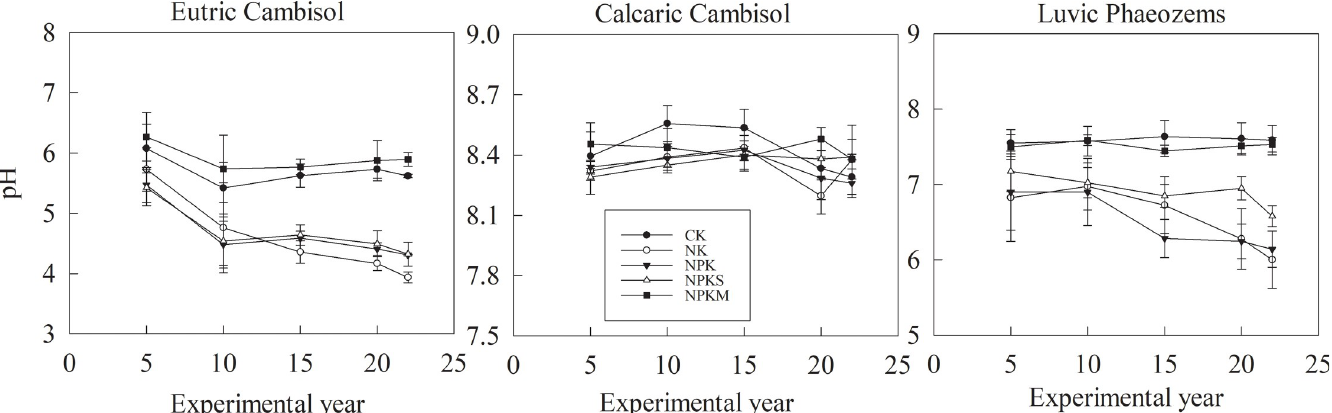
Fig 8. CK: Unfertilized control; NK: Nitrogen and potassium; NPK: Nitrogen, phosphorous, and potassium; NPKS: Nitrogen, phosphorous, potassium and straw; and NPKM: Nitrogen, phosphorous, potassium and manure (NPKM).